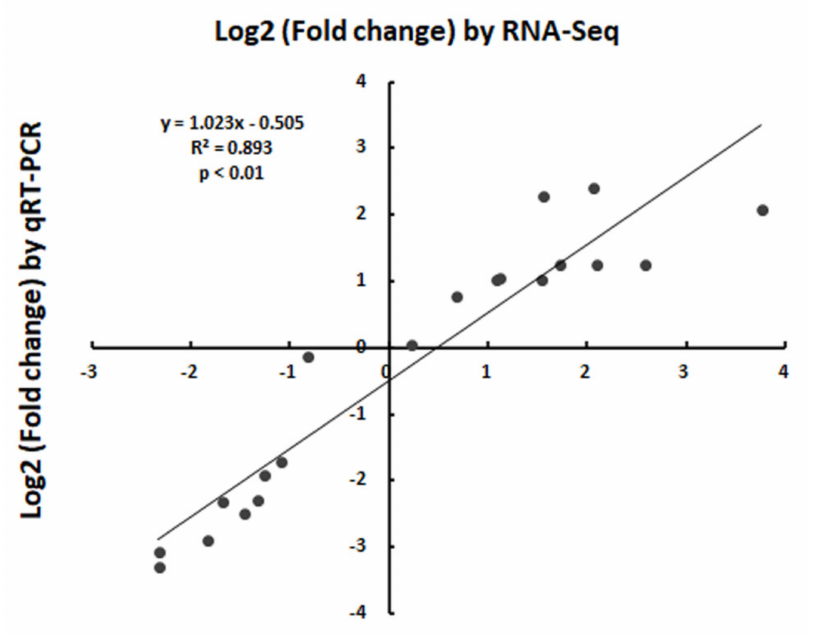
Figure 7. Validation of qRT − PCR. The Y -axis indicates the log 2 (fold change) by RNA − Seq; the X -axis indicates the log 2 (fold change) by qRT −